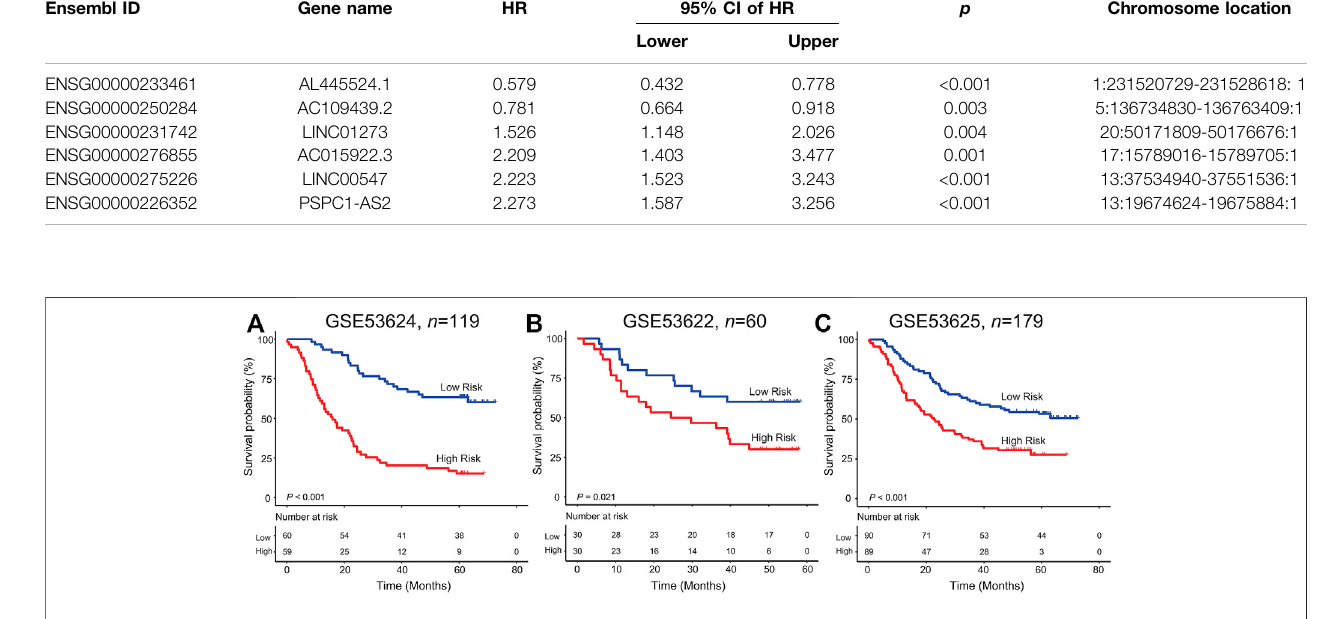
FIGURE 2 | Kaplan – Meier analysis of the six-lncRNA signature in the GSE53624 (A) , GSE53622 (B) , and GSE53625 (C) datasets.